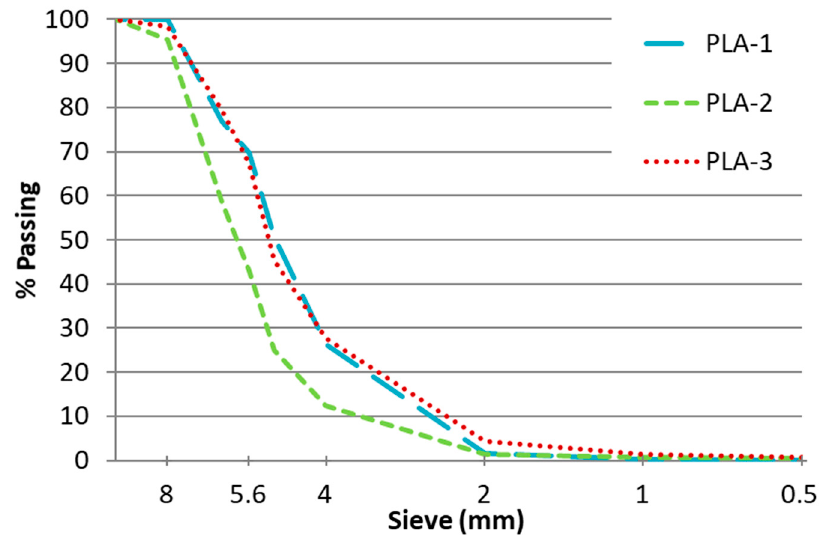
Figure 2. Granulometry of the analysed residual plastic.